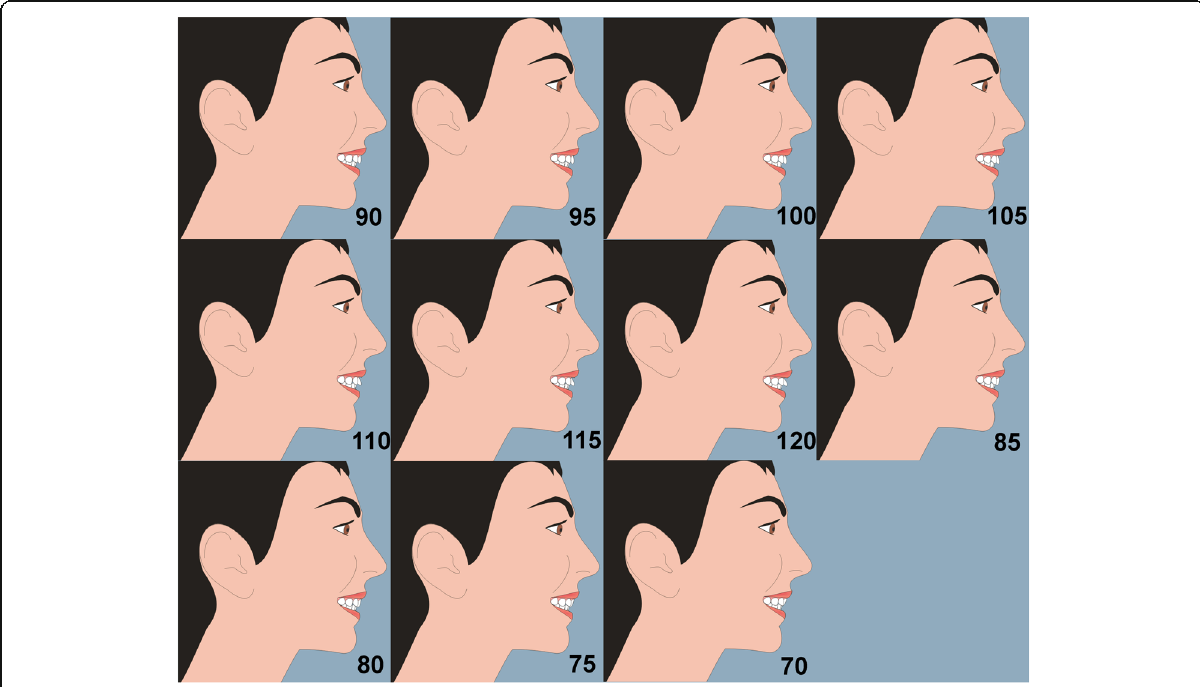
Fig. 3 The maxillary incisor labial face tangent was altered in 5° increments from 70 to 120°, creating a range of images. The annotation of the angles of inclination is shown here for ease of reference; these were not on the images shown to the observers